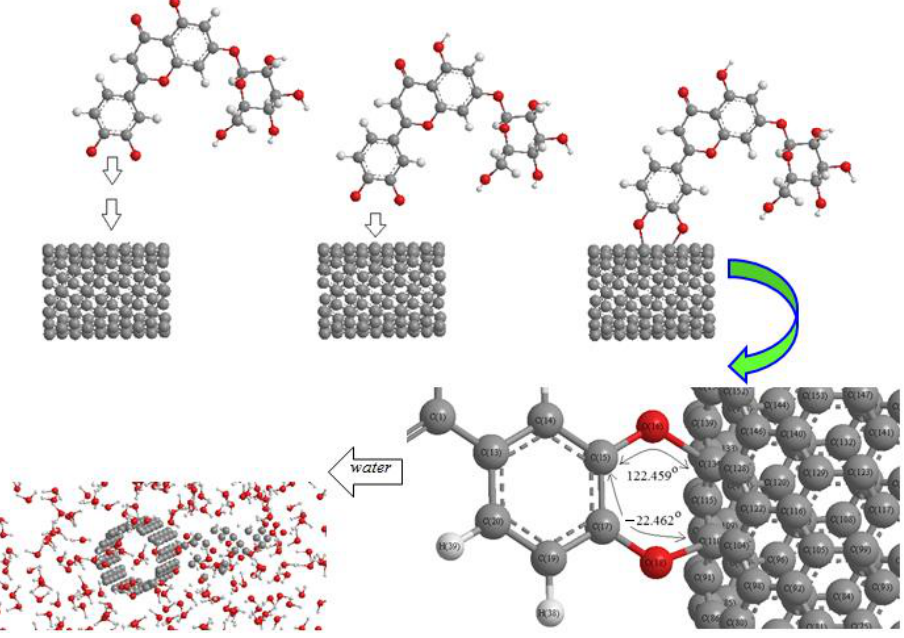
Scheme 2. Mechanism of adsorption of luteolin - 7 - O - glucoside onto the surface of (6,6) armchair SWCNT in a water medium at 300